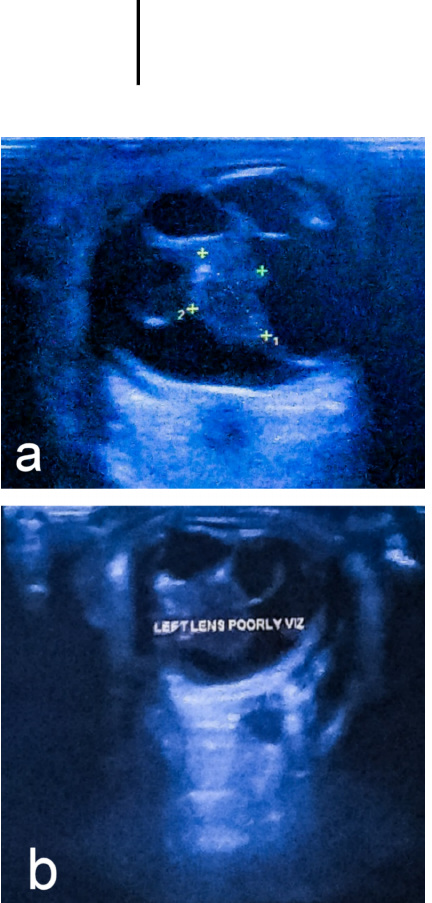
Figure 1: Ultrasound B-scan of (a) the right eye and (b) the left eye (b) showing an echogenic membrane extending from the retina to the posterior surface of the lens A B-scan revealed an ill-defined hyperechoic soft tissue lesion of size 10.3×7.4 mm in the right and 12.6×6.6 mm in the left posterior chamber (Figure 1). The lesion also shows hyper reflection echogenic linear strands with few debris. The bilateral lens appeared normal but the left lens capsule was thickened and compressed by the